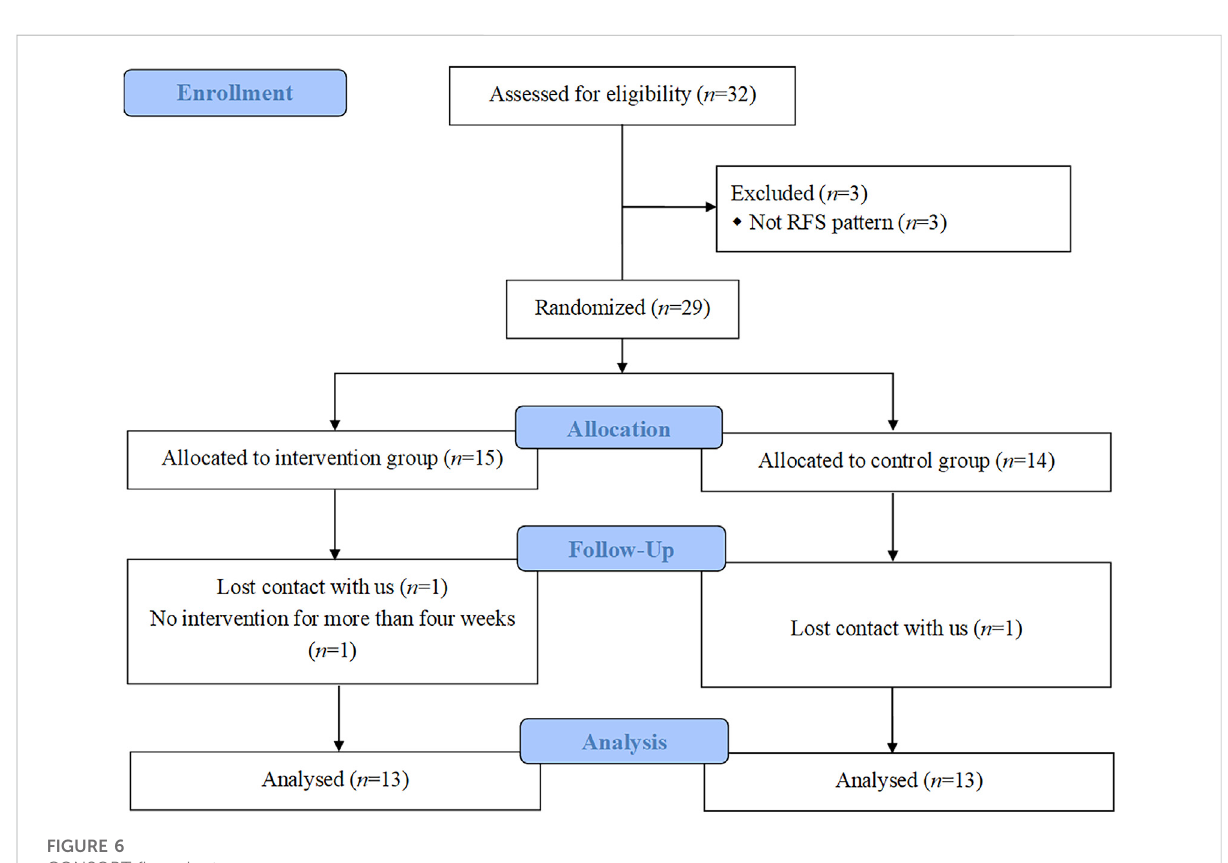
FIGURE 6 CONSORT fl ow